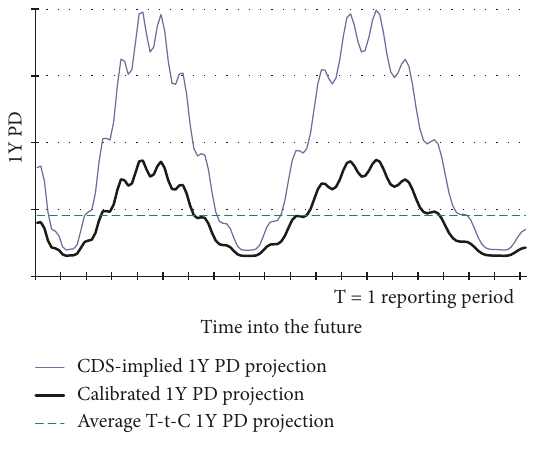
Figure 2: Illustrative 1Y PD